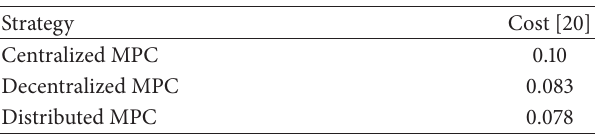
Table 2: Cost of the different